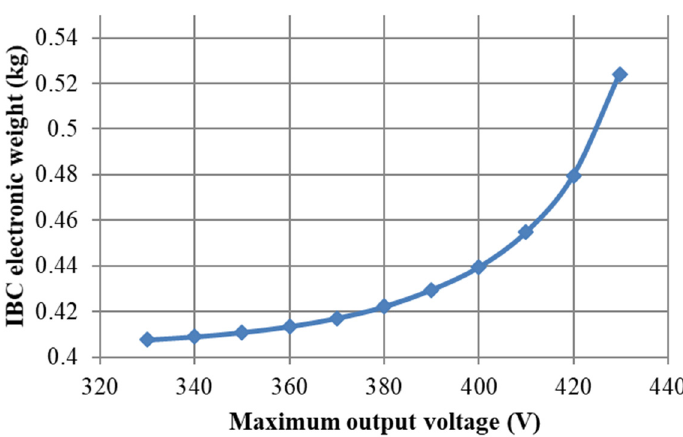
Figure 18. Parameterized optimization in the imaginary world of the IBC weight VS its maximum output voltage requirement.